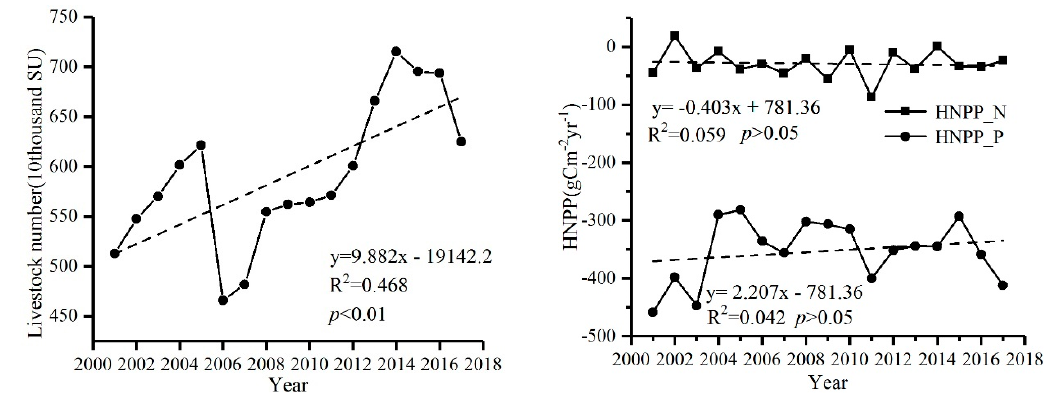
Figure 18. Inter-annual changes in livestock and HNPP multi-year average in Ningxia from 2001 to 2017.